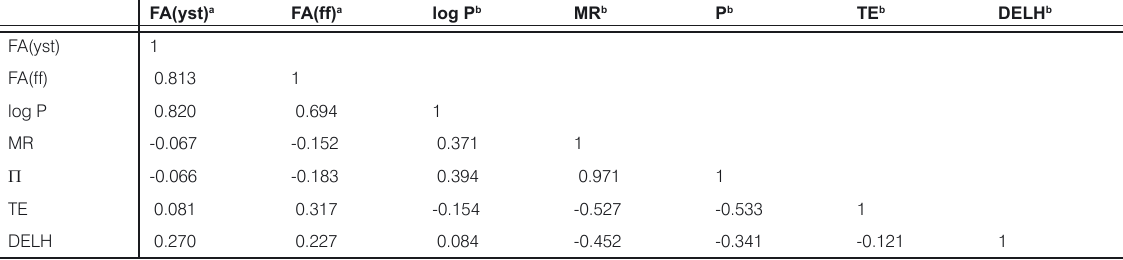
Table 2. Pearson correlation matrix of the parameters used in this study.